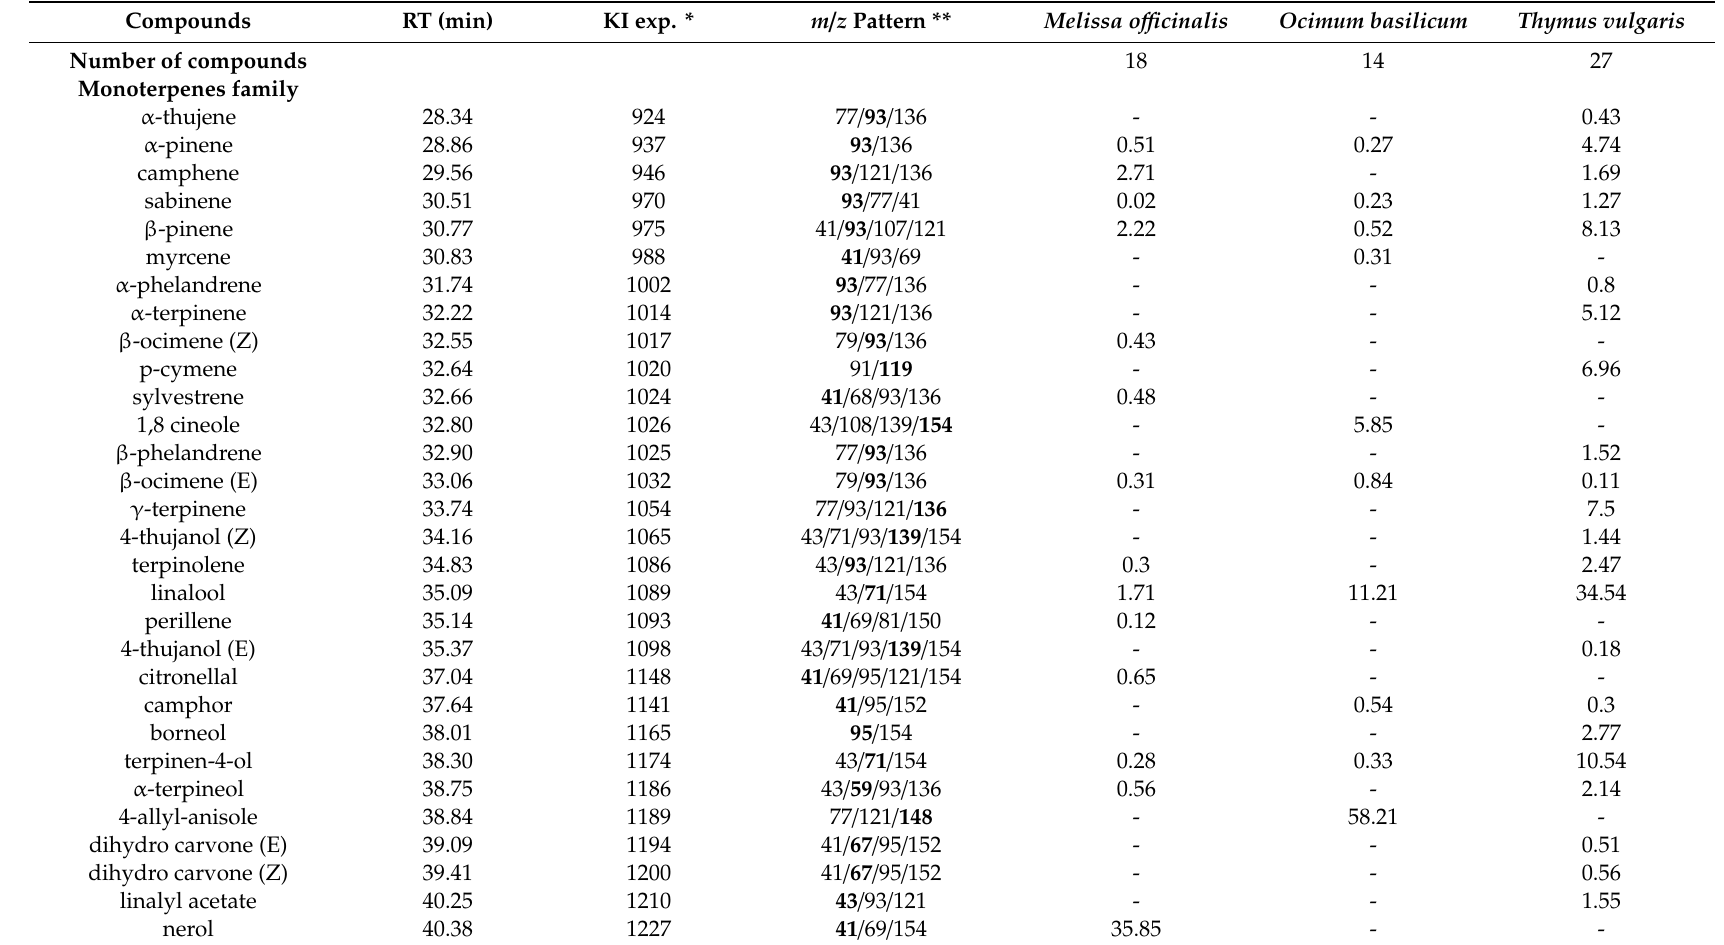
Table 1. Volatile composition of essential oils (EOs) expressed as relative area